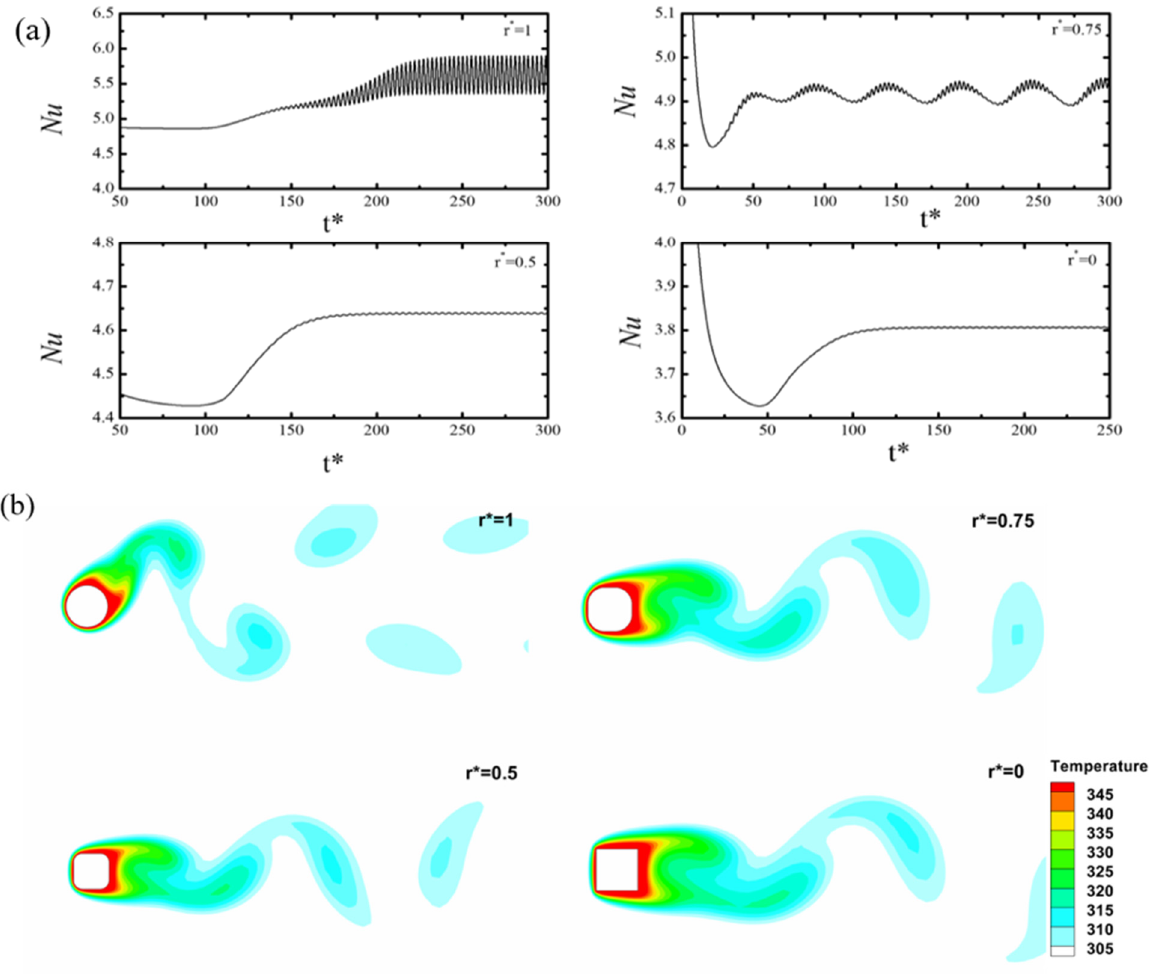
Figure 11. Effect of r* on heat transfer with vortex-induced vibration at Re = 100 and 𝑈𝑟 = 4.92. ( a ) Time histories of the lift coefficient. ( b ) Temperature contour of the different radius corners.